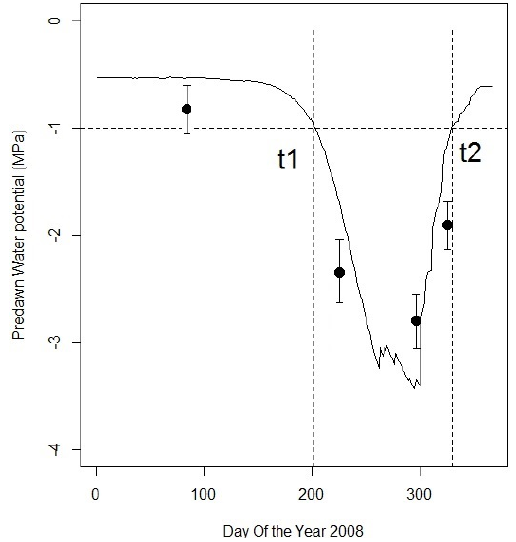
Figure 6. Daily predawn leaf water potentials for Quercus suber measured (black dots, mean and standard deviation) during the year 2008, and simulated (black line). The horizontal dotted line illustrates the − 1 MPa threshold, from day of the year which drought onset t 1 and drought offset t 2 are deduced when the simulated predawn water potential reaches this threshold.